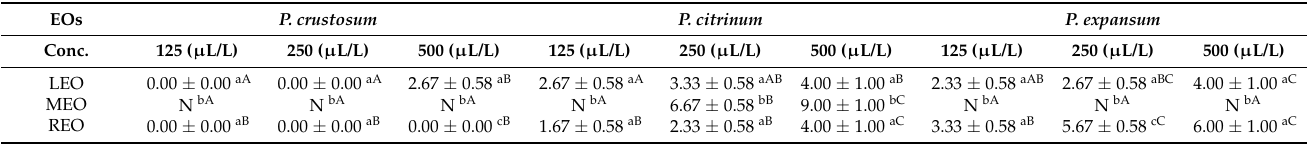
Table 4. Antifungal activity of EOs (inhibition zone in